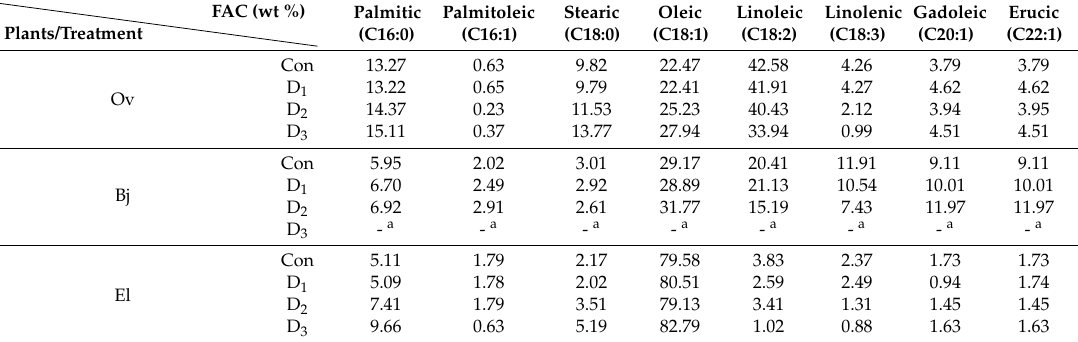
Table A1. Fatty acid composition (FAC) of three energy plant species oil